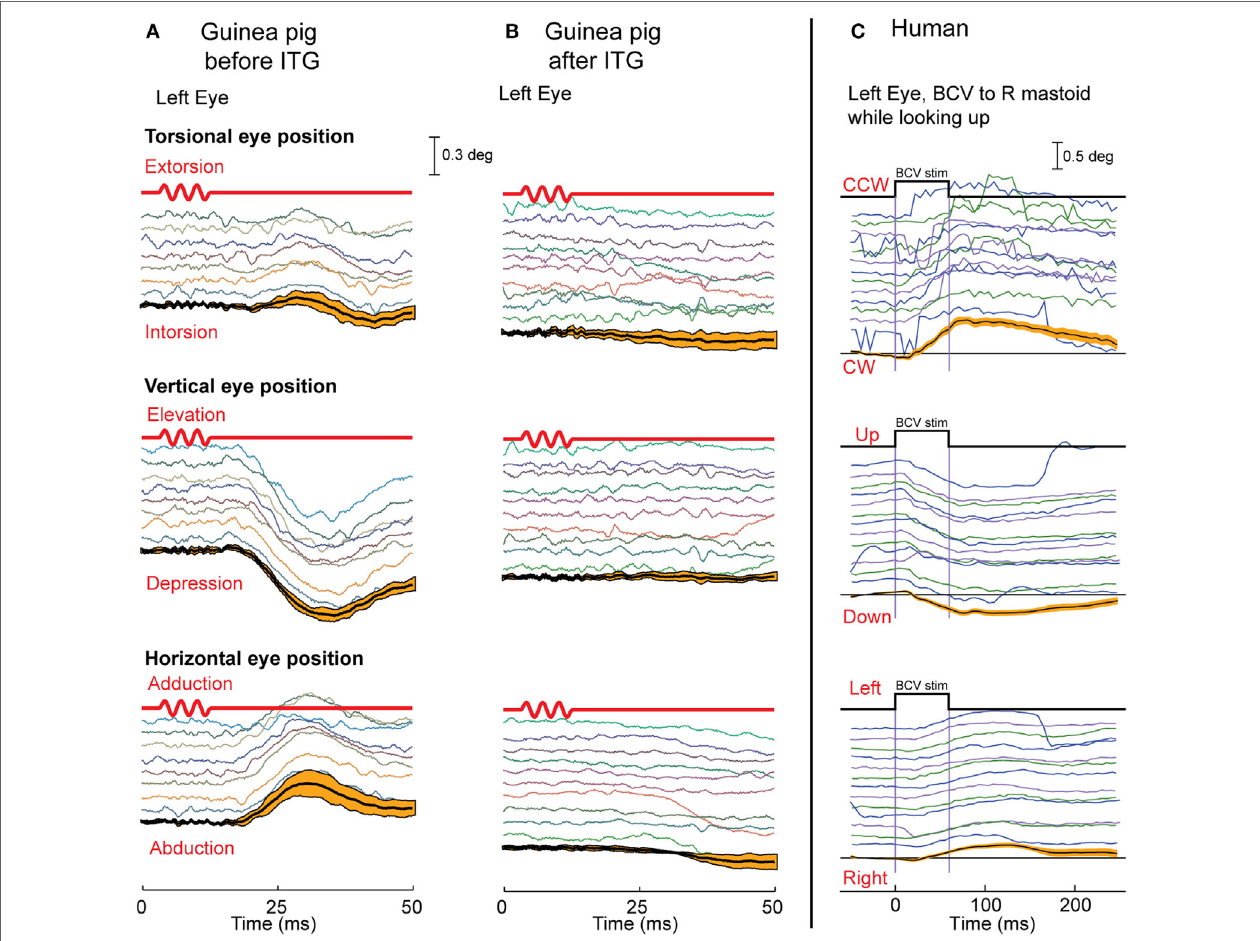
FigURe 7 | The eye movements in guinea pigs (A,B) and humans (C) in response to bone-conducted vibration (BCV). Each panel shows time series of torsional, vertical, and horizontal components of eye position in response to repeated tone bursts of 500 Hz BCV; below the traces are the mean and 95% confidence intervals (orange bars) calculated over responses to multiple stimuli. (A,B) The first line in red is the command voltage for the 500 Hz BCV stimulus. The eye movements in guinea pigs are eliminated (B) by intratympanic gentamicin which selectively attacks type I receptors. In humans (C) , a small vibration applied to the mastoid (start and end time shown by the top black trace) elicits stimulus-locked torsional, vertical, and horizontal eye movements. (A,B) Reprinted from Vulovic and Curthoys (67), © 2011, with permission from